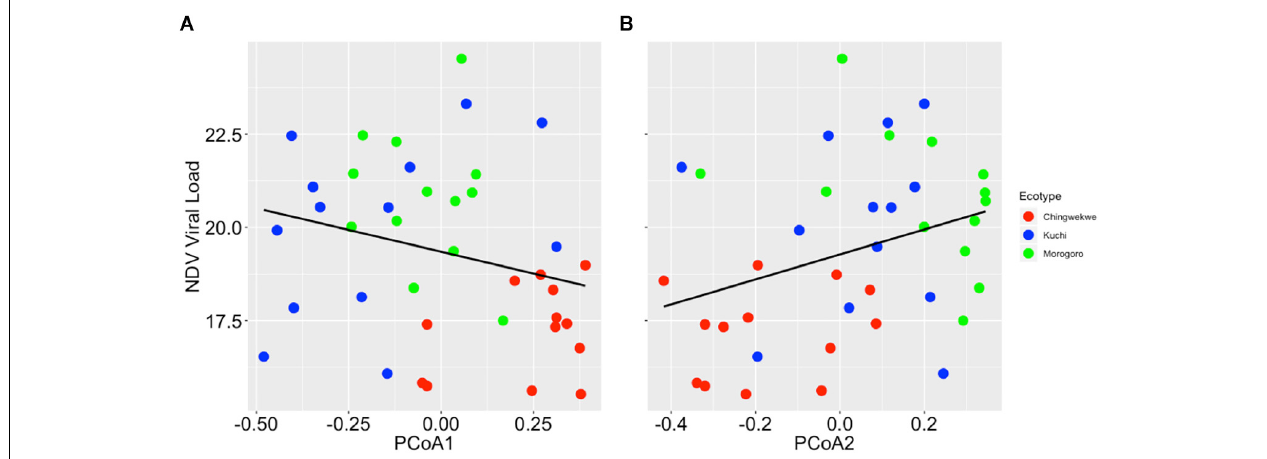
FIGURE 4 | Relationship between principal coordinate (PCoA) axis and NDV viral load. (A) The NDV viral load versus the PCoA axis 1 (0.30 ± 0.26, p -value = 0.05). The expression of NOS2 is most representative for PCoA axis 1. (B) The NDV viral load versus the PCoA axis 2 (0.30 ± 0.30, p -value = 0.05). The expression of CCL4, CAMP, and IL8 are most representative for PCoA axis 2.